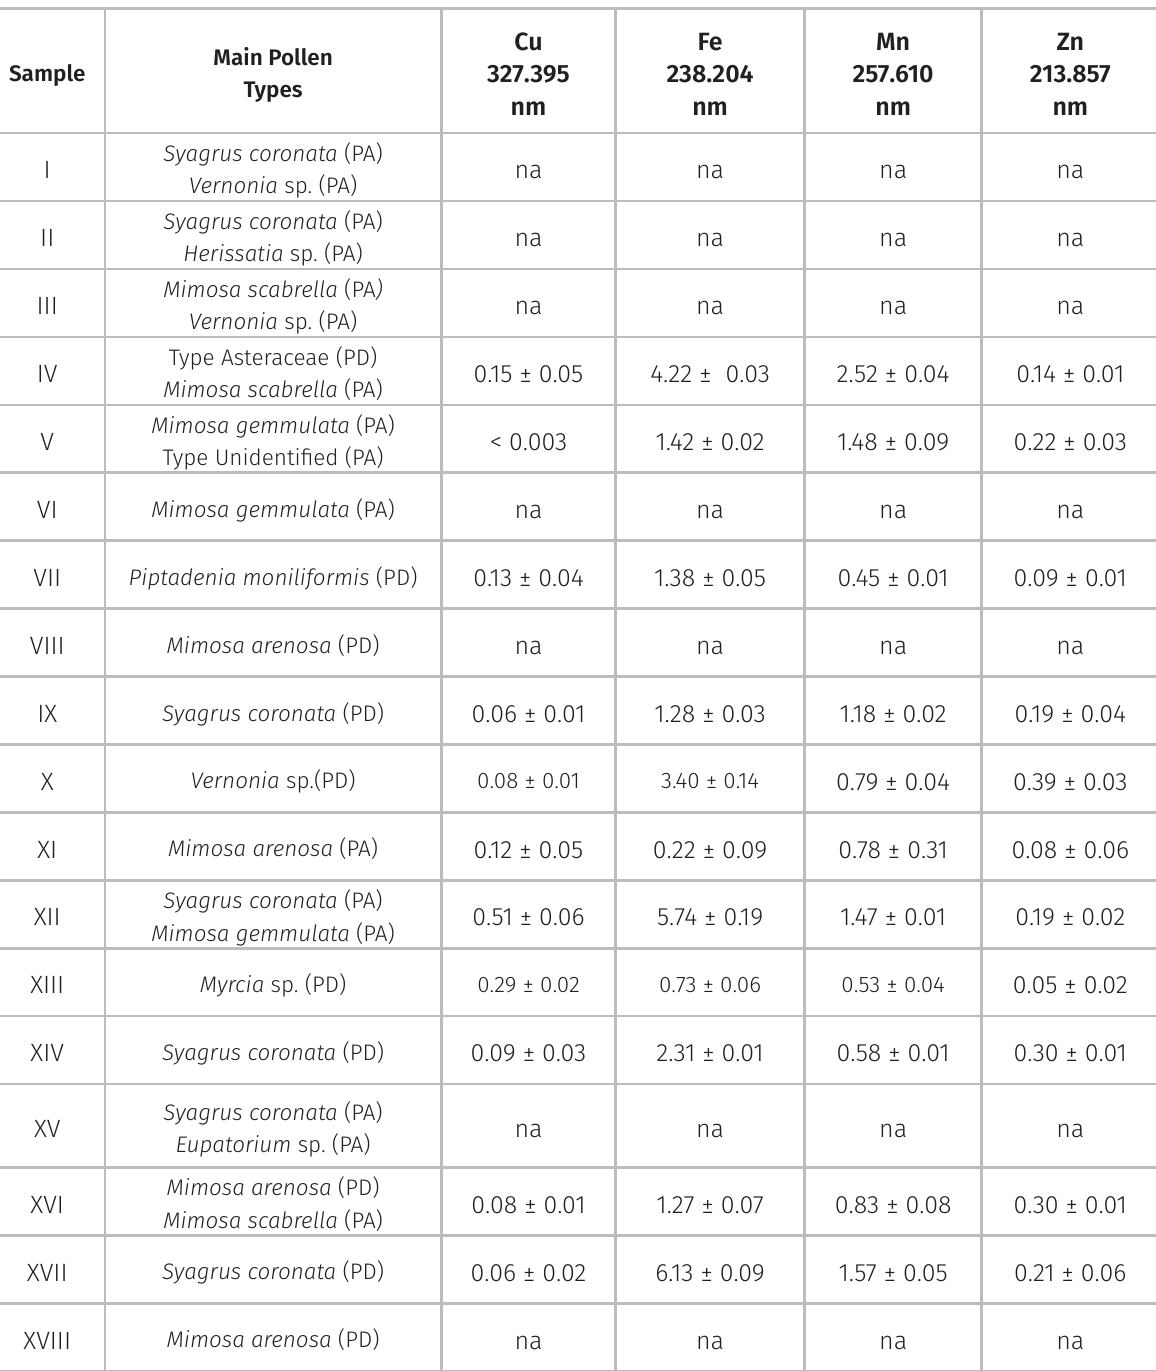
Table VI. Composition of micronutrients (Cu, Fe, Mn, and Zn) in honey samples marketed in municipalities of Paraguaçu River/Bahia region (mg Kg -1